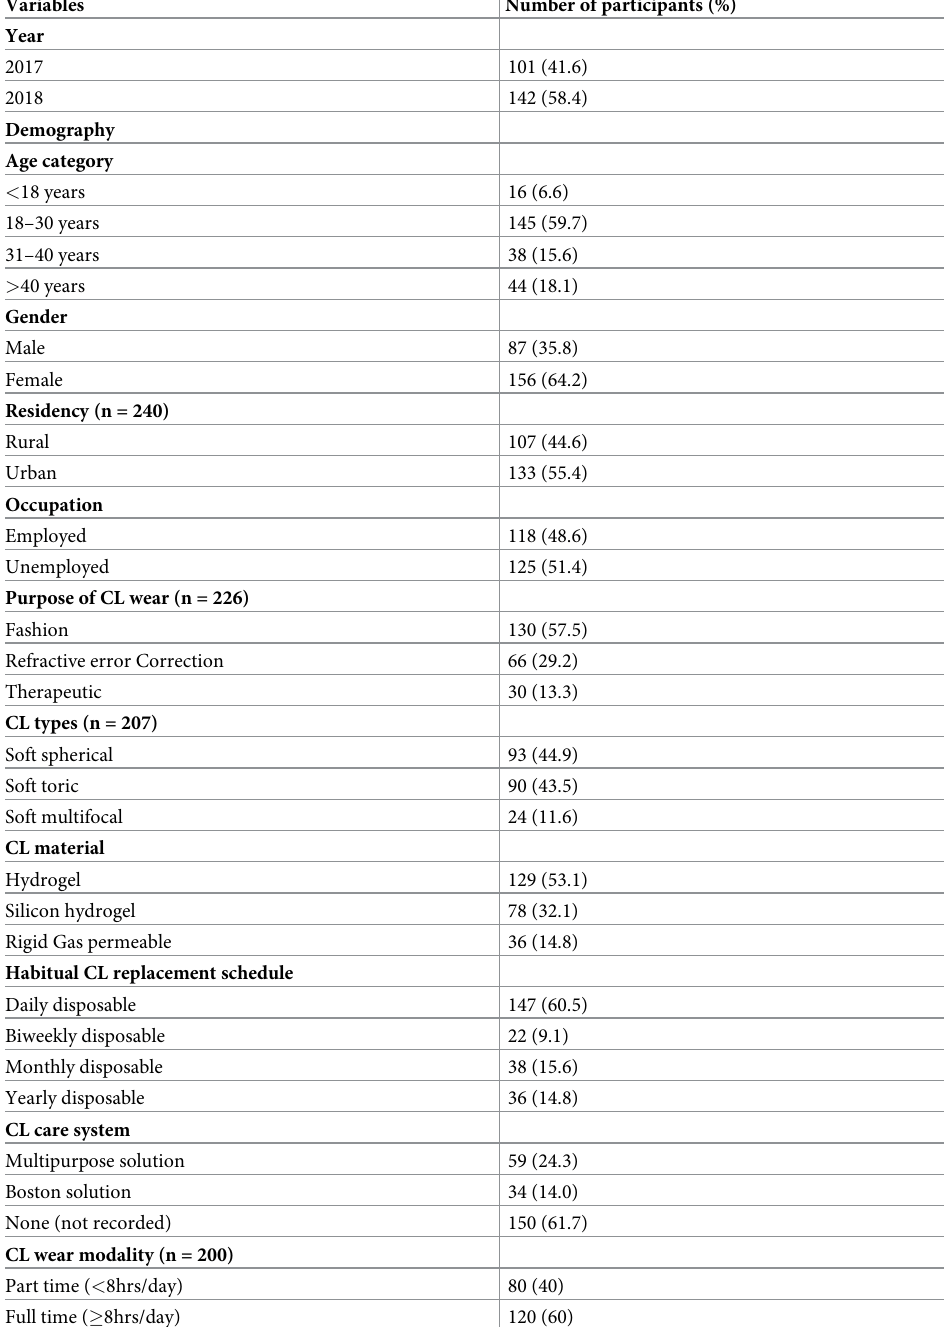
Table 1. Demographic characteristics of the participants and CL-related variables (n = 243 unless otherwise